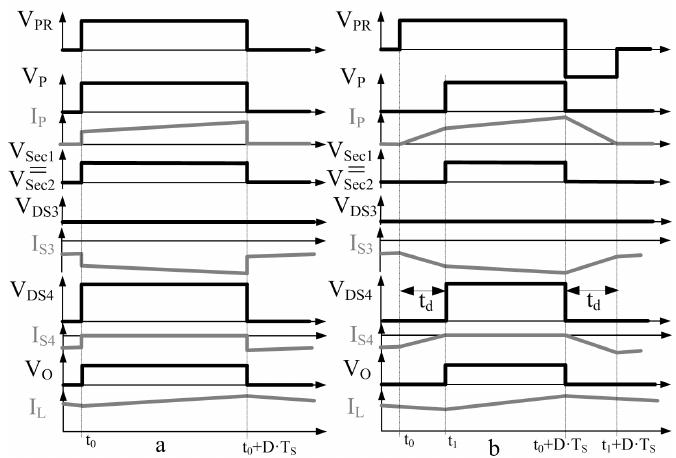
Figure 11. ( a ) Switching waveforms with ideal transformer. ( b ) Switching waveforms with overall leakage inductor at the primary